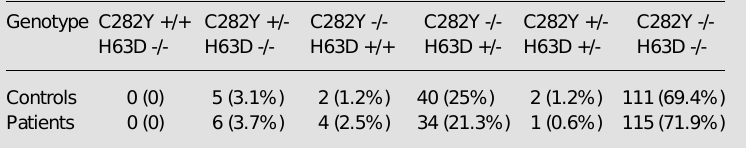
Table 3 - Hereditary hemochromatosis genotypes for controls and for myocardial infarction patients. C282Y and H63D indicate Cys282Tyr and His63Asp, respectively. None of the differ- ences shown in this table was statistically significant